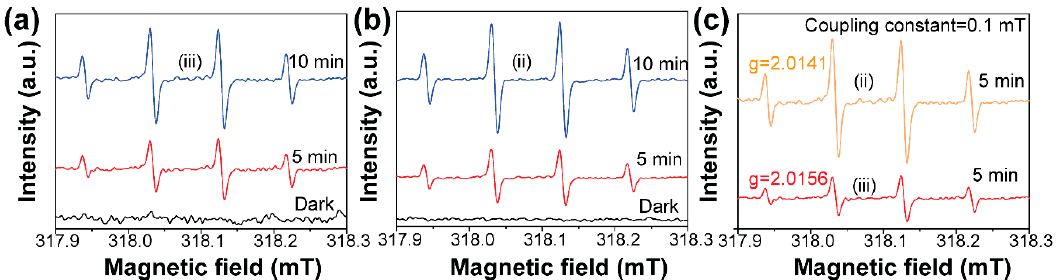
Figure 5. DMPO spin-trapping electron spin resonance (ESR) spectra recorded for · OH under visible light with various illumination time for ( a ) Bi 2 WO 6 and ( b ) BiOCl/ Bi 2 WO 6 hybrids. ( c ) The intensity comparison of production of BiOCl/ Bi 2 WO 6 (ii) and Bi 2 WO 6 (iii) under 5 min illumination.